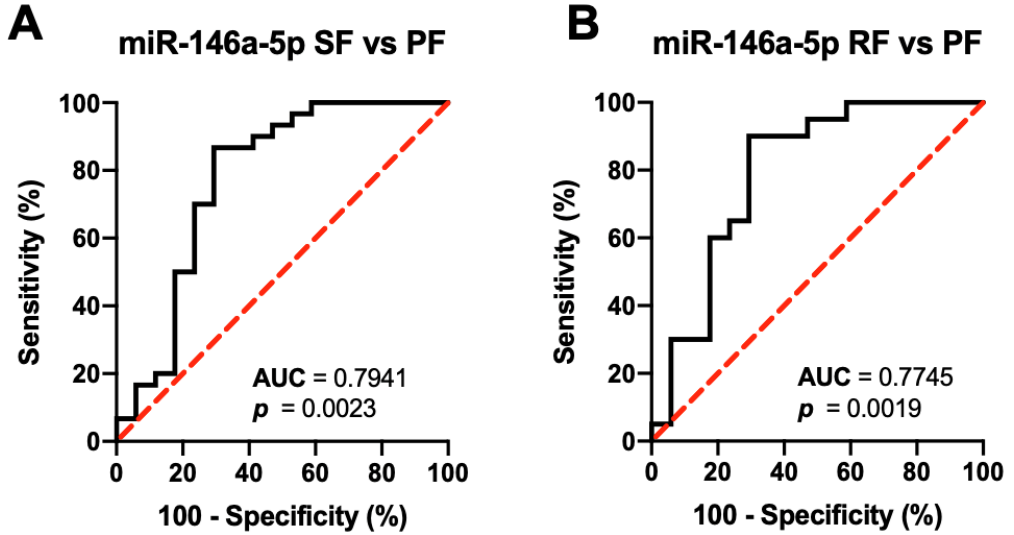
Figure 4. Differentiation of patients with progressive fibrosis (PF, n = 17) from those with ( A ) stable US findings (SF, n = 30) and ( B ) reversal of fibrosis (RF, n = 20) by baseline serum levels of the 6 target miRNAs. Note : p- values were computed using Wilson/Brown test.